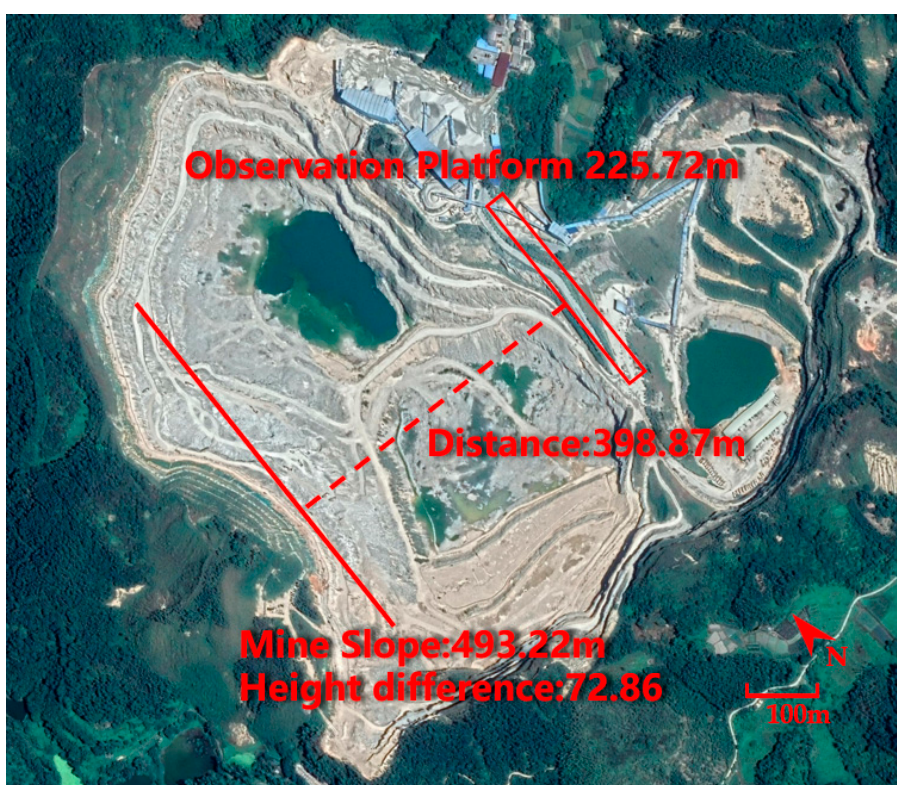
Figure 11. Study field located in Shunxing Quarry in Guangzhou, Guangdong, China. In the field, GPS sampling was used to locate camera points and set up the cameras. Multiple photos extracted from camera videos were prepared as the inputs. We used Smart3D software for the data preprocessing, aerial triangulation, dense matching of oblique images, DSM point cloud generation, triangulated irregular network (TIN) con- struction, texture mapping, model modification, and other processes, in order to produce a realistic 3D model, as Figures 12 and 13 show.